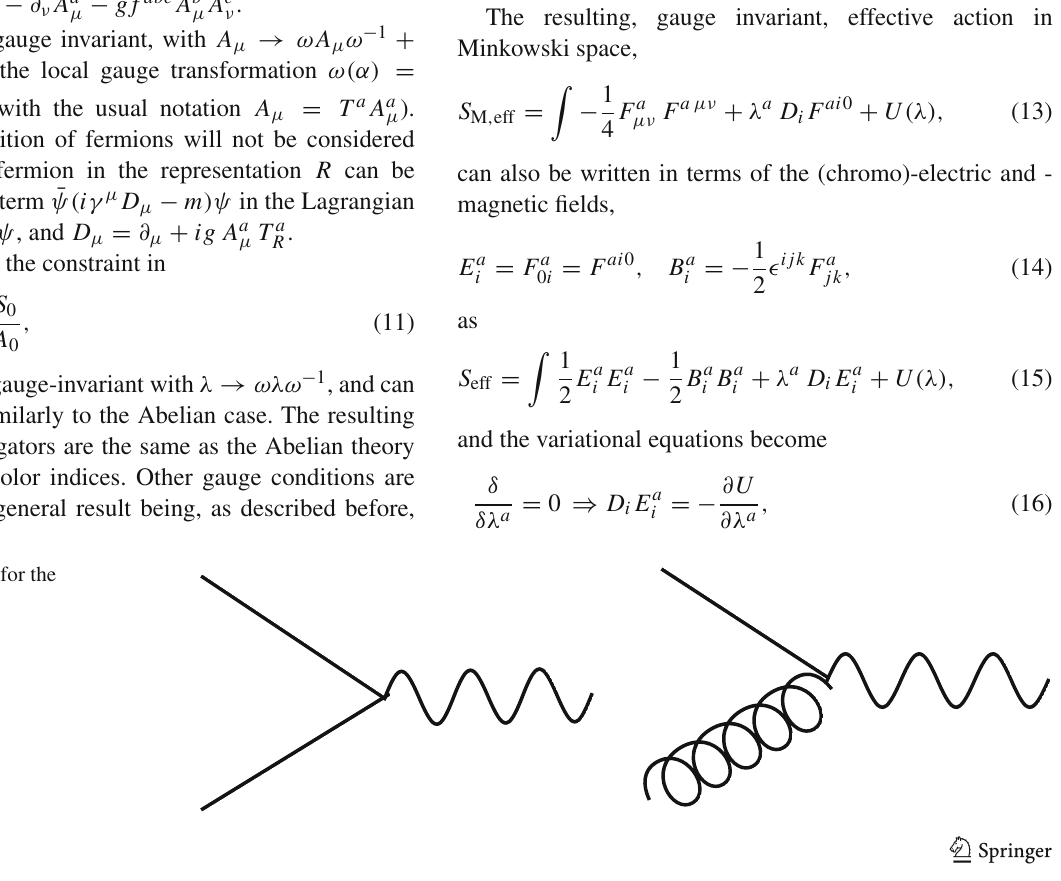
erators T a and structure constants f abc , and initial action